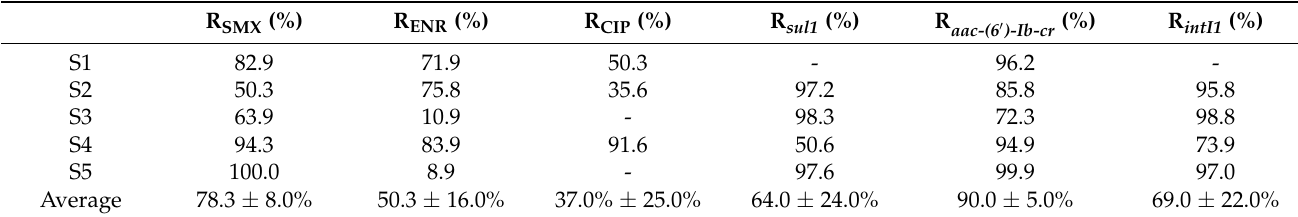
Table 1. SMX, CIP, ENR, ARGs and intI1 gene removal percentage (R %) calculated between input and output samples. S1: In Feb -Out Apr ; S2: In Apr -Out Jun ; S3: In Jun -Out Jul ; S4: In Jul -Out Sep ; S5: In Sep -Out Oct.